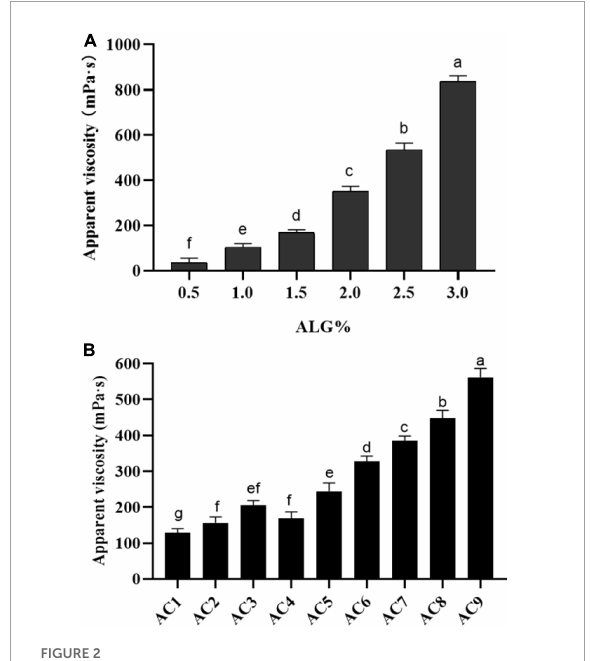
FIGURE2 Apparent viscosity of ALG and ALG-CG encapsulation solutions. (A) Apparent viscosity of ALG with different concentrations. (B) Different proportions of ALG-CG, AC1-AC9 represents polysaccharide mixtures in different proportions. Different letters a–g indicate significant differences ( p < 0.05).